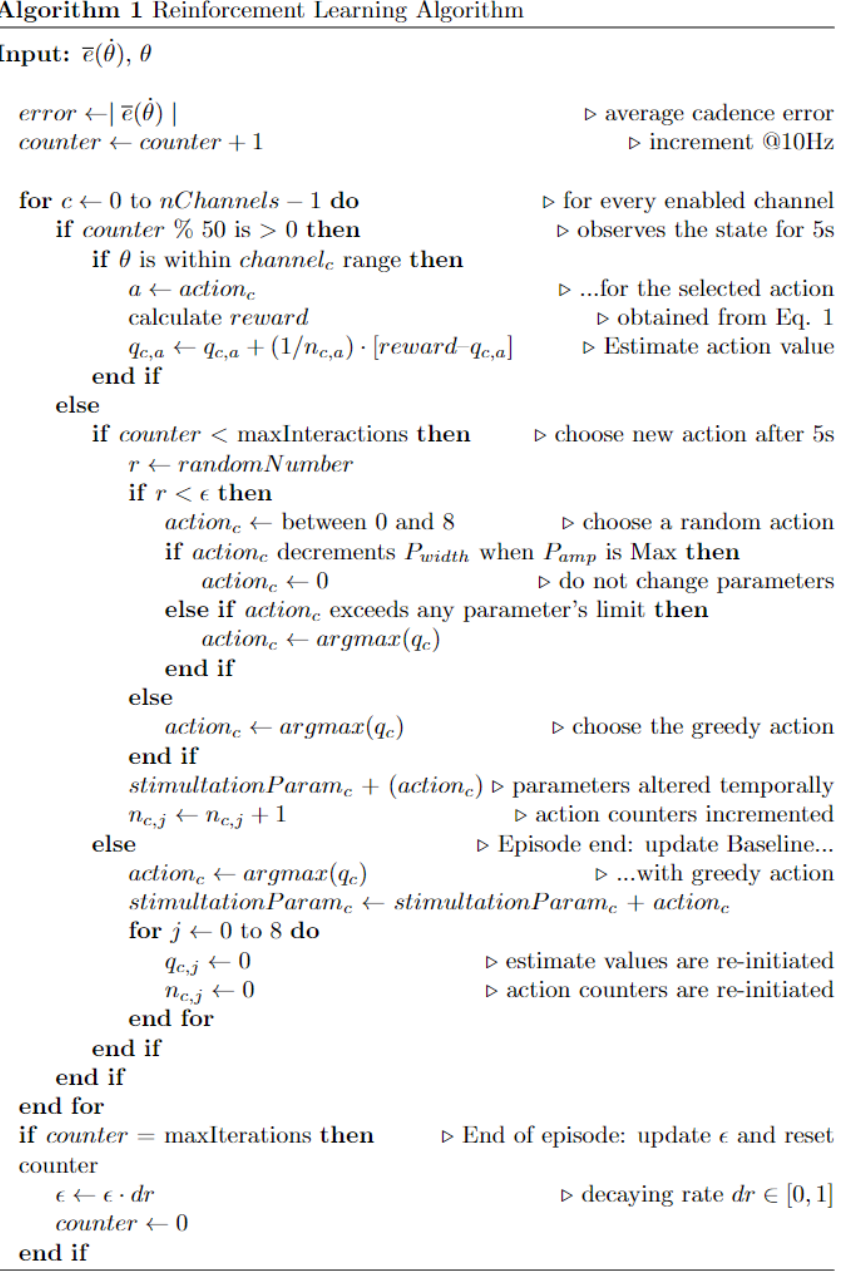
Figure 3. Principle behind the implemented decayed-epsilon-greedy RL Algorithm.